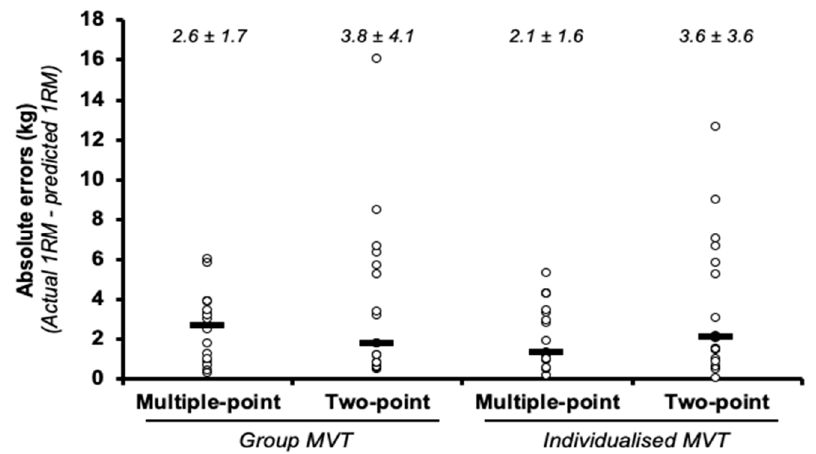
Figure 1. Comparison of the absolute differences (mean ± standard deviation) between the actual one-repetition maximum (1RM) and the 1RM estimated using the different prediction methods in the bench press exercise. Note: the black rectangle denotes the median value, while the circles represent individual data points.